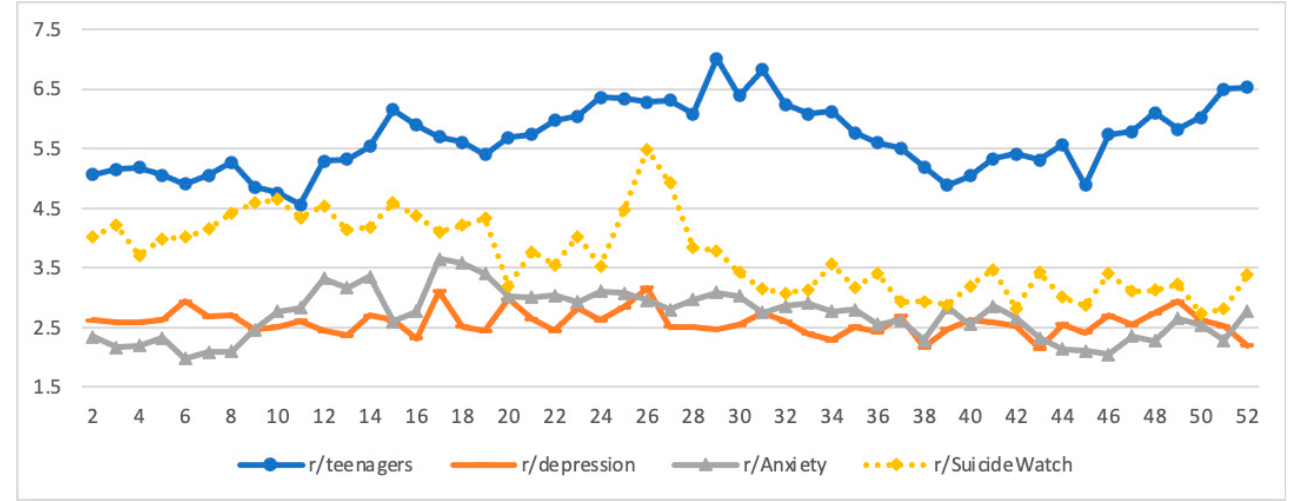
Figure 2. Weekly mean number of posts/comments per participant by